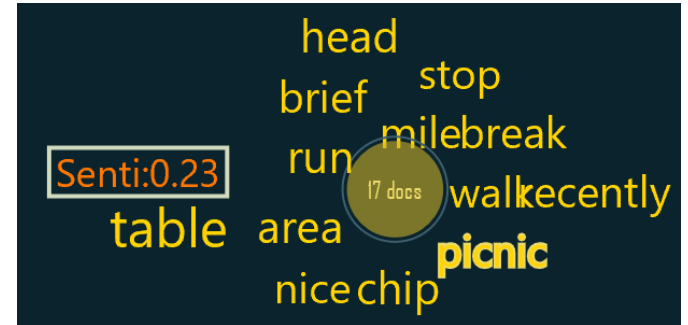
Figure 8. Word cloud of “picnic” generated by